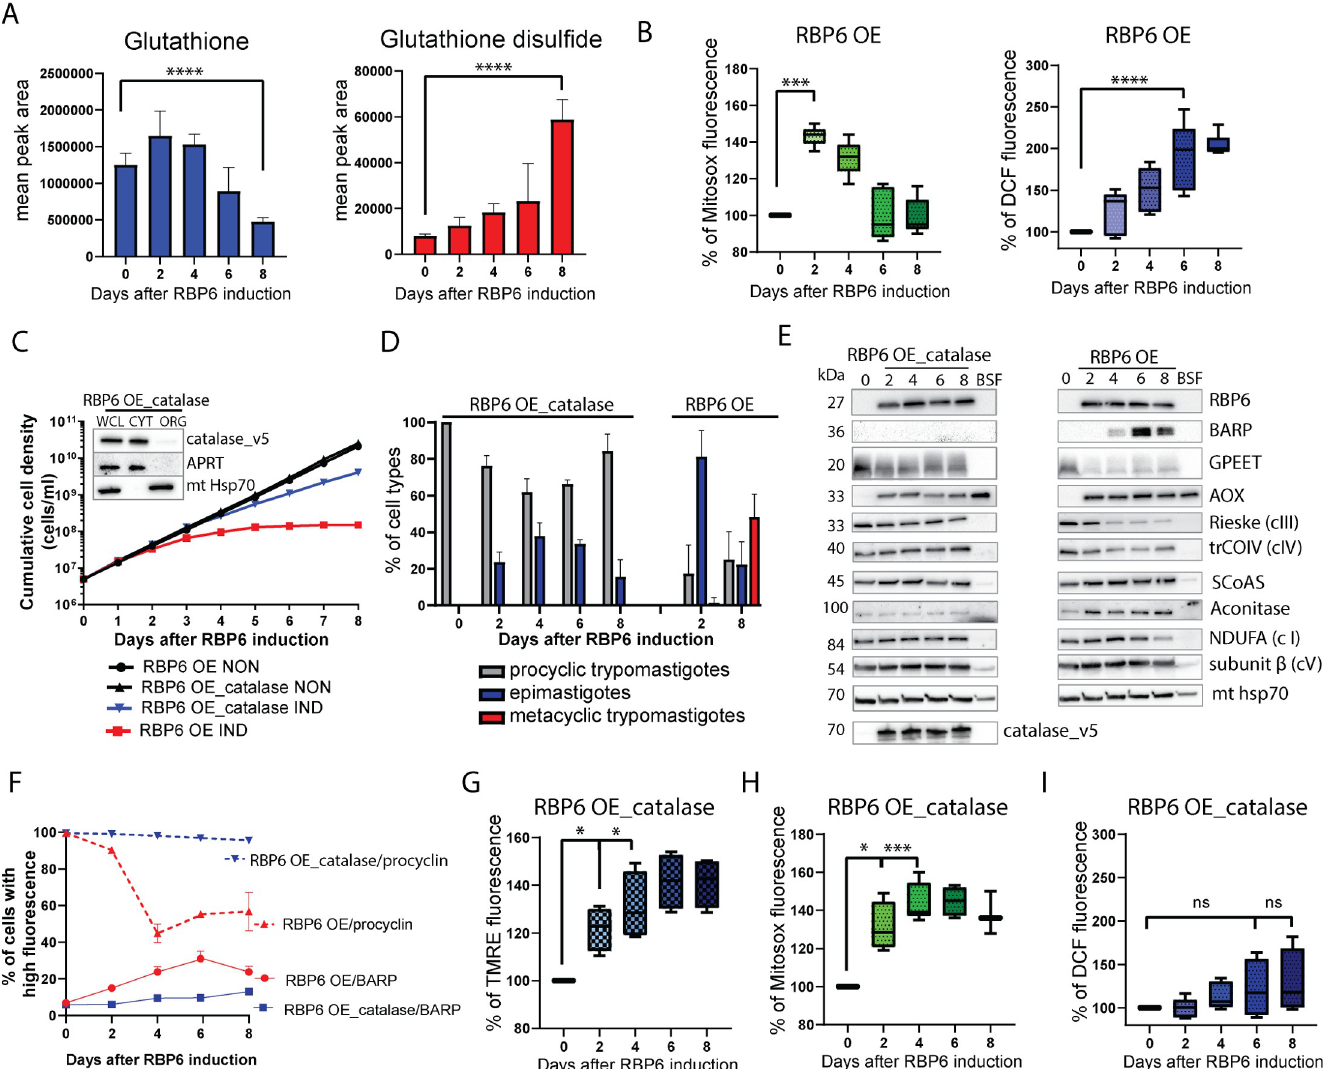
Fig 10. Elevated ROS generated during the differentiation of T . brucei are crucial for driving forward RBP6-induced differentiation. (A) Metabolites glutathione and glutathione disulfide as detected by LC-MS analyses. The size of the bars represents the total abundance of the metabolite (mean ± SD, n = 4, ��� P < 0.001). (B) Mitochondrial and cellular ROS detection reagents (MitoSox and H 2 DCFDA, respectively) were quantified by FACS (means ± SD, n = 5, ��� P < 0.001, ���� P < 0.0001). (C) Representative growth curves of RBP6 OE and RBP6 OE _catalase cells induced by tetracycline. Total number of experiments n = 5. The inset shows subcellular localization of v5-tagged catalase in RBP6 OE _catalase cells induced for 48 hours. Immunoblots were labeled with anti-v5, anti-adenosine phosphoribosyl transferase (APRT), and anti-mt hsp70 antibodies to visualize catalase, cytosolic APRT, and mitochondrial localized hsp70, respectively. (D) Time line for the appearance of epimastigotes and metacyclic cells upon induction of RBP6 OE and RBP6 OE _catalase. Total number of experiments n = 3. (E) Western blot analysis of whole-cell lysates from RBP6 OE and RBP6 OE _catalase cells using available antibodies. (F) FACS analyses of RBP6 OE and RBP6 OE _catalase cells treated with 5 mM bathophenanthroline disulphonic acid (BPS) and labeled with polyclonal anti-BARP and anti-procyclin antibodies. (G) The Δ ψ m of RBP6 OE _catalase cells post induction measured by flow cytometry using TMRE (means ± SD, n = 4), � P < 0.05. (H) Mitochondrial ROS detection reagent MitoSox in RBP6 OE _catalase cells quantified by FACS (means ± SD, n = 5), � P < 0.05, ��� P < 0.001. (I) Cellular ROS detection reagent H 2 DCFDA in RBP6 OE _catalase cells quantified by FACS (means ± SD, n = 5). Underlying data plotted in panels A, B, C, D, F, G, H, and I are provided in S1 Data. AOX, alternative oxidase; APRT, adenine phosphoribosyl transferase; BARP, brucei alanine-rich protein; CYT, cytosol; hsp70, heat shock protein 70; H 2 DCFDA, 2 0 ,7 0 -dichlorofluorescin diacetate; LC-MS, liquid chromatography–mass spectrometry; ns, statistically not significant; ORG, organellar fraction; RBP6, RNA binding protein 6; ROS, reactive oxygen species;